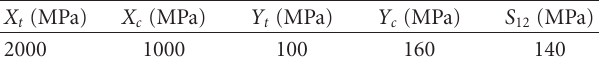
Figure 11: Element loaded-unloaded-reloaded in tension and compression in the matrix direction. Table 2: Ply strengths.